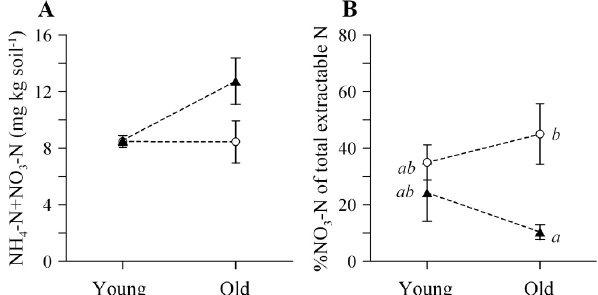
Fig. 4. Stand averages of total extractable mineral N (mg N (NH 4 - N+NO 3 -N) kg − 1 dry soil) (A) in the top 0–15cm of the mineral soil, (B) the percentage of NO 3 -N to total extractable mineral N in the top 0–15cm of the mineral soil. Error bars represent the stan- dard error of the mean. Oak ( N ) and Norway spruce ( ◦ ). Significant differences between stands marked with different letters. Dashed lines are included for clarification and do not represent regression lines.